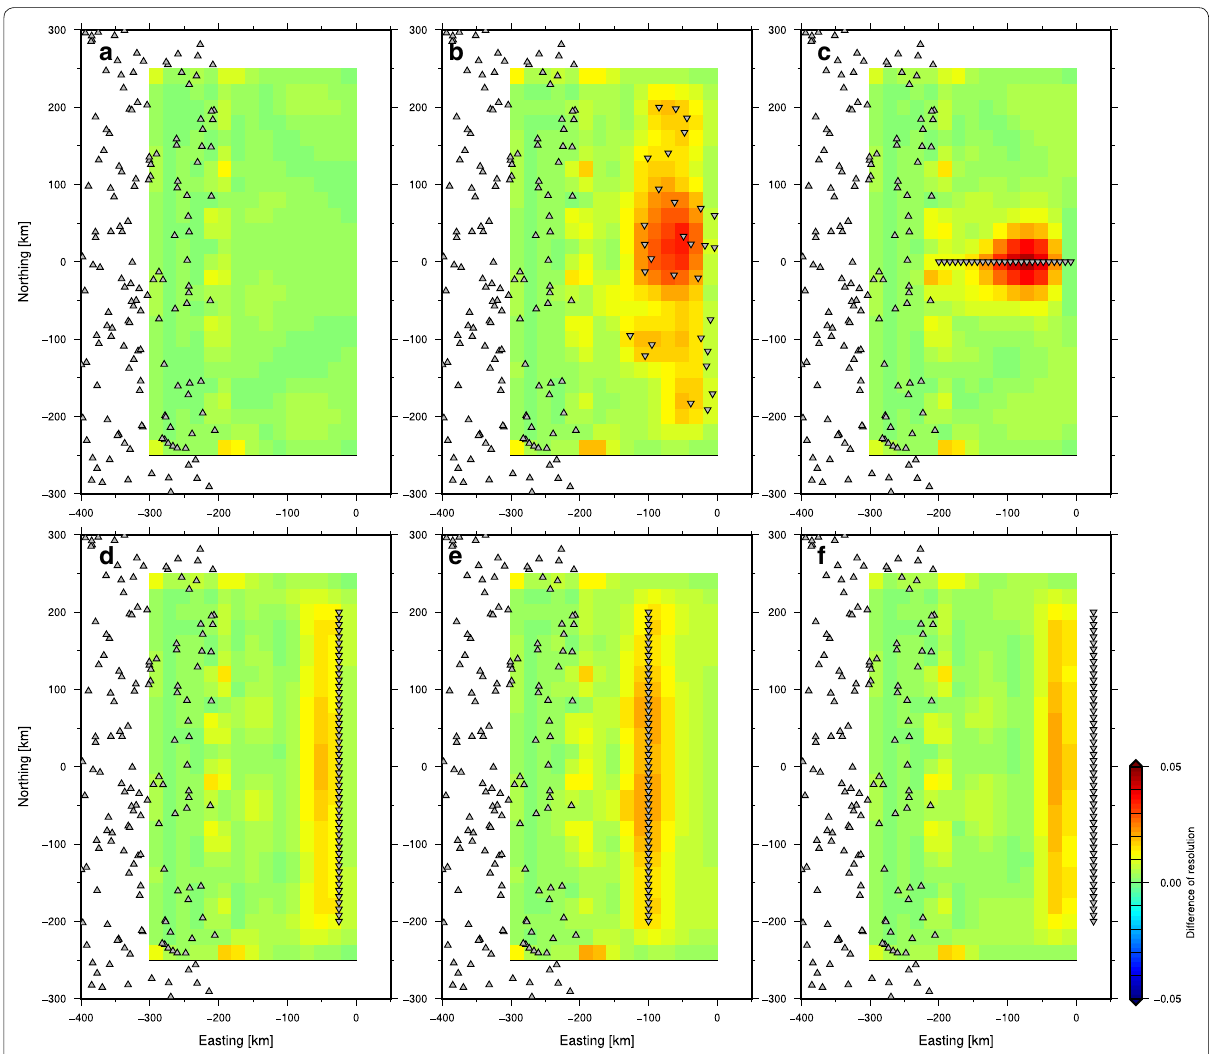
Fig. 10 Improvement of the spatial resolution assuming various postseismic site distributions for the dip–slip case. Each panel shows difference of the spatial resolution on the coseismic slip same as with Fig. 9c assuming different site distributions. Gray triangles indicate the observational sites during both the co- and the post-seismic periods, while inverse gray triangles indicate the observational sites only during the postseismic